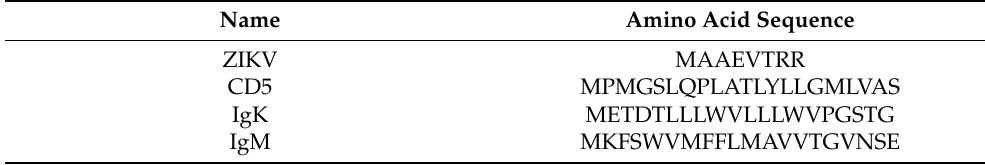
Table 1. Signal sequences of different origins used for recombinant